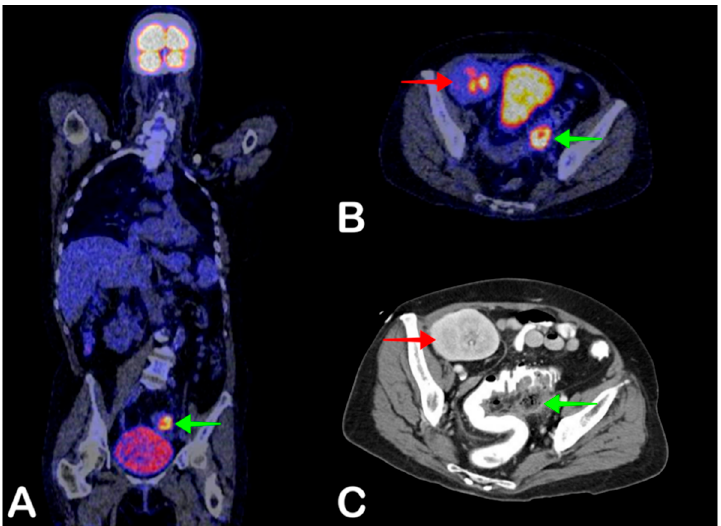
Figure 1. A 54-year-old woman was admitted to the hospital with fever. During hospitalization, she repeatedly had blood cultures positive for Escherichia coli and Klebsiella pneumoniae without localizing symptoms. Two years earlier, she had received a kidney transplant. Fused coronal2- deoxy-2-[18F]fluoro-D-glucose Positron Emission Tomography combined with Positron Tomography (FDG-PET/CT) showed increased FDG uptake at the left side of the sigmoid colon ( A , green arrow), also shown on fused axial FDG-PET/CT ( B , green arrow), indicative of either diverticulitis or abscess formation, as an explanation for the positive blood culture ( Escherichia coli ). Antibiotic treatment was started, but 9 days after PET/CT, the patient developed severe abdominal pain, and abdominal CT was performed. Axial CT also shows the abscess, with adjacent free intraperitoneal air, in keeping with perforated diverticulitis ( C , green arrow). The kidney transplant in the right iliac fossa is also visible ( B and C , red arrow). A laparotomic sigmoidectomy was performed, after which the patient recovered.